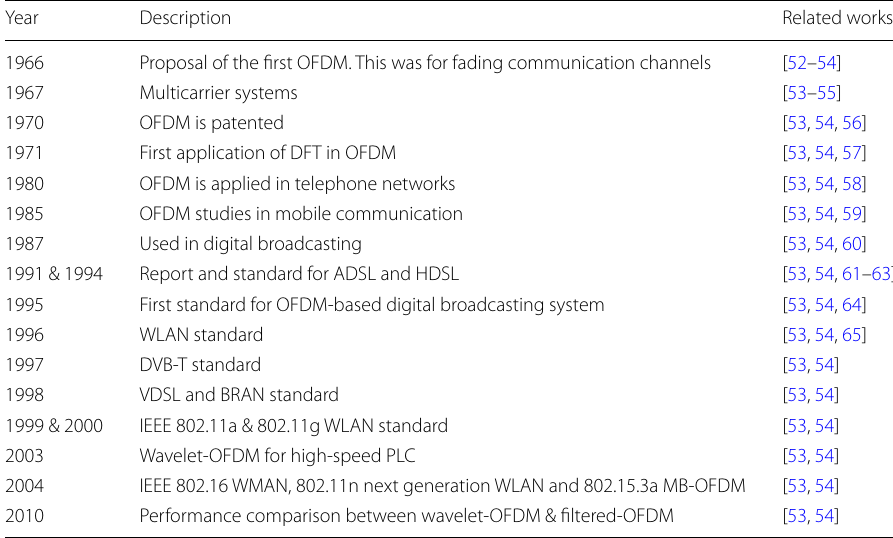
Table 4 History of